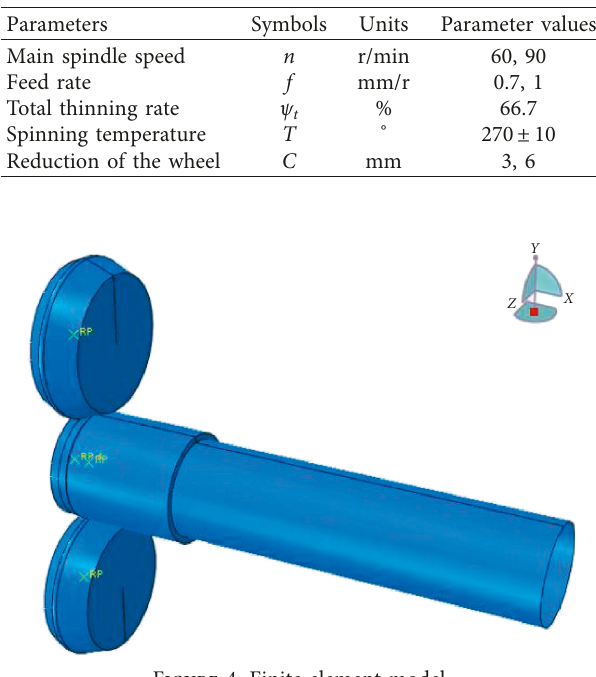
Table 2: Basic process parameters of spinning simulation.